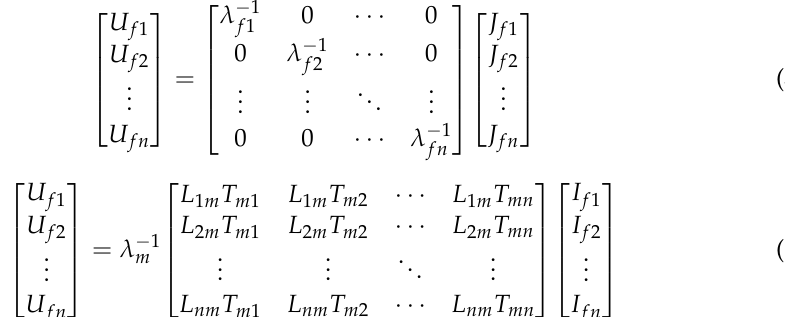
. Figure 2. Mathematical model of capacitive current feedback active damping control method. 150 100 50 0 50 M a g n i t u d e ( dB )